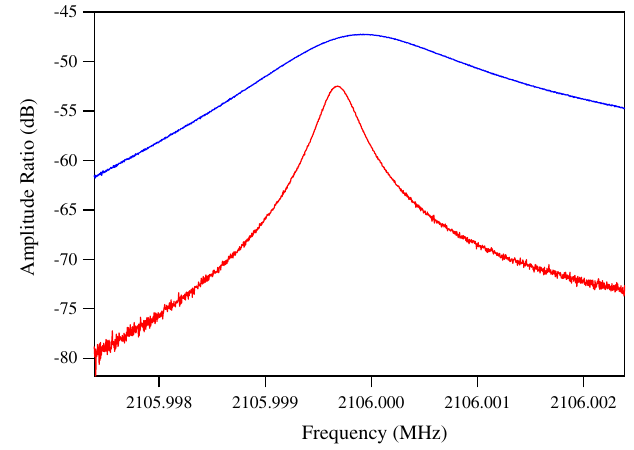
FIG. 12. (Color) The effect on the Q of the 2106 MHz mode with the cavity-based, narrowband feedback off (red curve represents Q (cid:1) 6 : 2 (cid:10) 10 6 ) and on (blue curve represents Q (cid:1) 1 : 3 (cid:10) 10 6 ).